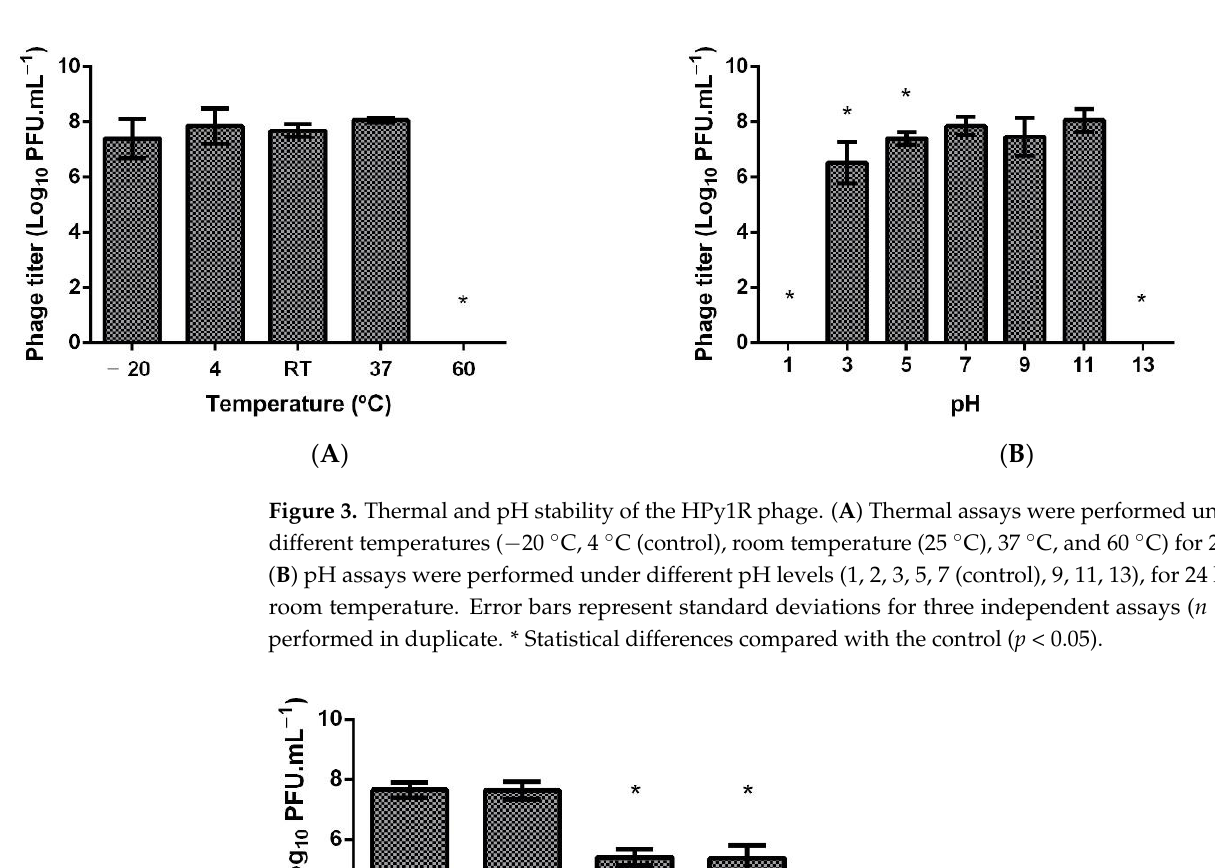
Figure 3. Thermal and pH stability of the HPy1R phage. ( A ) Thermal assays were performed under different temperatures ( − 20 °C, 4 °C (control), room temperature (25 °C), 37 °C, and 60 °C) for 24 h. ( B ) pH assays were performed under different pH levels (1, 2, 3, 5, 7 (control), 9, 11, 13), for 24 h at room temperature. Error bars represent standard deviations for three independent assays ( n = 3) performed in duplicate. * Statistical differences compared with the control ( p < 0.05).